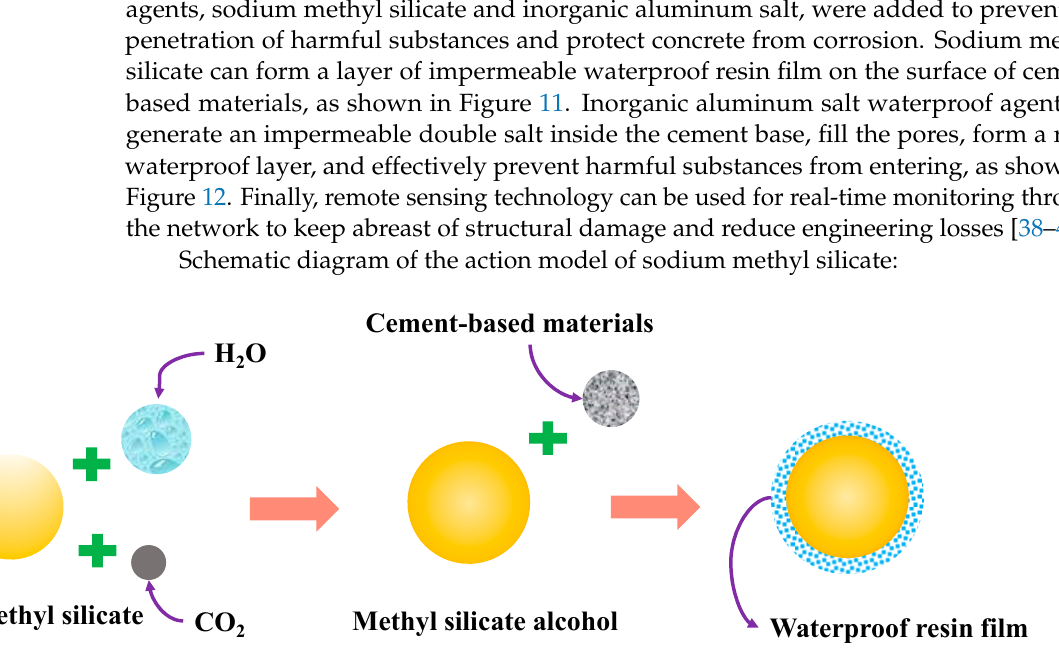
Figure 11. Sodium methyl silicate action model.